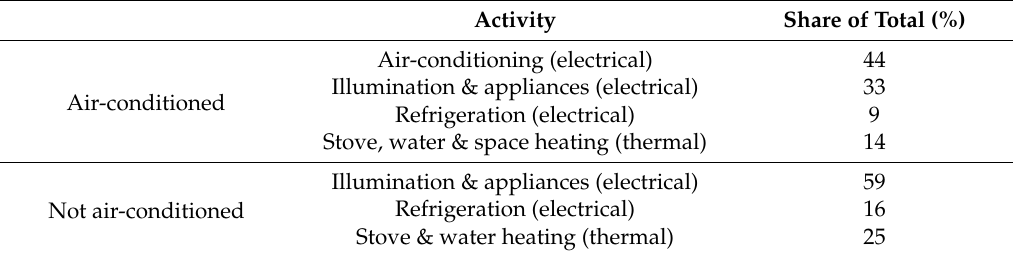
Table 2. Share of the different energy use in air-conditioned and not air-conditioned dwellings in Mexico